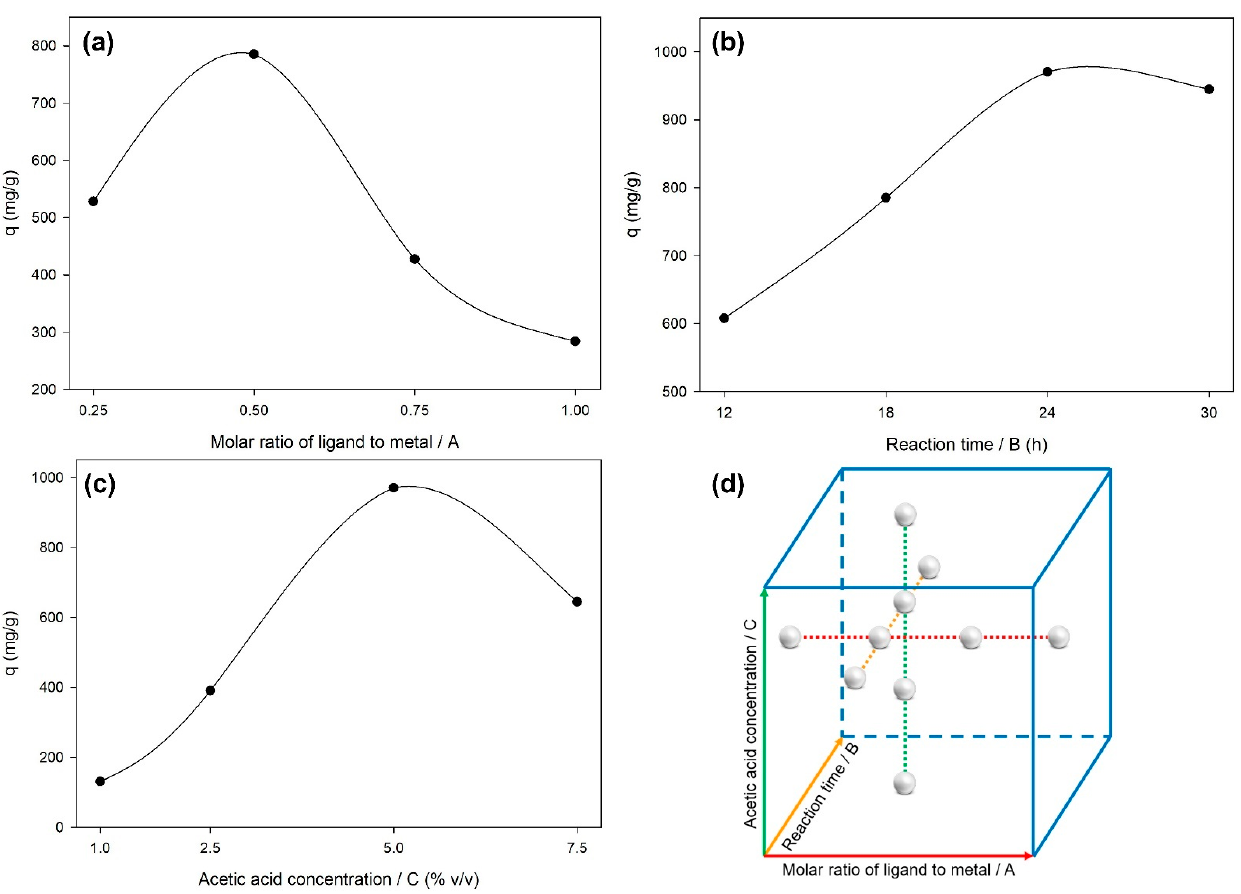
Figure 1. Simulation of levels of ( a ) molar ratio of ligand to metal, ( b ) reaction time, and ( c ) acetic acid concentration towards the response by ( d ) OFAT method. Table 1. Actual and predicted responses based on experiments designed with CCD of RSM.